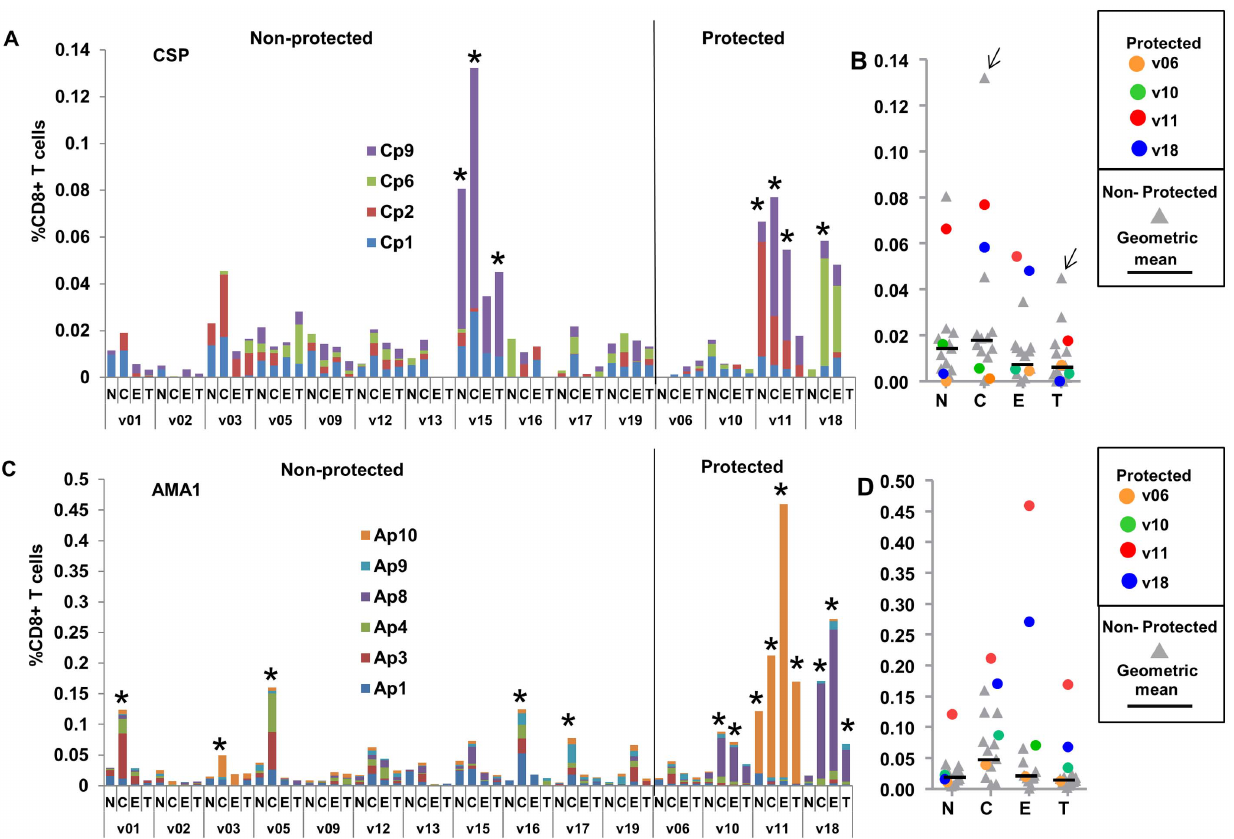
Figure 4. DNA/Ad CD8 + T cell memory IFN- c activities to CSP and AMA1 peptide pools. Panels A and C: CD8 + T cell IFN- c activities of each volunteer to CSP or AMA1 peptide pools 22/23 days after the Ad boost are shown as color coded stacked bars, differentiating memory naı¨ve (N), central (C), effector (E) and terminally differentiated (T) cells (per cent of CD8 + T cells) to CSP and AMA1 peptides as color-coded bars. Non-protected and protected volunteers are grouped. *Positive activities (defined in Methods). Panels B and D: CD8 + T cell IFN- c memory activities were summed and are shown as color-coded dots. Horizontal bars represent geometric mean activities of non-protected volunteers. The geometric means of summed activities of non-protected volunteers and the activities of each protected volunteer are shown in Table 1. Panel A: CSP: among non- protected volunteers, only one (v15) had positive CM and TD activities and none had positive EM activities. One protected volunteer (v11) had positive CM, EM and TD activities whereas protected v18 had only positive CM activity. Positive CM, EM and TD activities were predominantly directed to single CSP peptide pools. Panel B: the geometric mean of CM and EM activities of non-protected volunteers were lower than protected v11 and v18, except CM activity of non-protected v15 (arrow). Panel C: AMA1: five non-protected volunteers only had positive CM activities, whereas protected v10 had positive CM and EM, and v11 and v18 had positive CM, EM and TD activities that were mostly directed to single AMA1 peptide pools. Panel D: AMA1: the geometric mean of CM activities of non-protected volunteers was similar to v10 but lower than v11 and v18; however, protected v10, v11 and v18 were above the geometric means of EM and TD activities of non-protected volunteers. doi:10.1371/journal.pone.0106241.g004 AdCA had higher IFN- c ELISpot responses than any of the four protected volunteers from DNA/Ad, 2/16 had higher IFN- c CD8 + T cell responses, and for CD8 + T cell EM responses, while none were higher than the highest responses in the protected volunteers in DNA/Ad, the overall ranges of activities and percent positive were similar. In the case of CD8 + T cell CM IFN- c activities, 5/16 and 11/16 AdCA volunteers to CSP and AMA1 respectively were higher than those of the four protected volunteers in DNA/Ad (Table 1). Also strikingly, activities in the non-protected AdCA volunteers were generally much more robust than those of the non-protected volunteers from DNA/Ad, and this difference was statistically significant for all measures (Table 1). We conclude that, while ELISpot, CD8 + T cell and CD8 + T cell EM IFN- c activities were higher in protected than non-protected volunteers in the DNA/Ad trial, many non- protected volunteers in AdCA demonstrated activities that were as high as or higher than those of the protected volunteers in DNA/Ad. In contrast to the protected volunteers in the DNA/Ad (Table 1). For example, 11/18 non-protected volunteers from